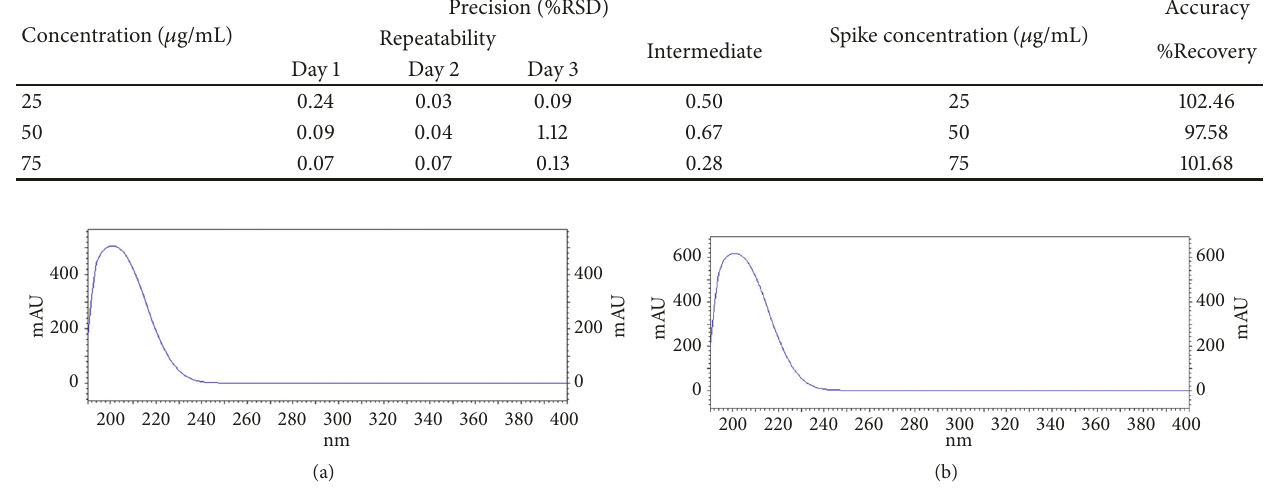
Figure 2: UV spectrums at (a) center of the peak of nitrate and (b) center of the peak of nitrate in V. cinerea .